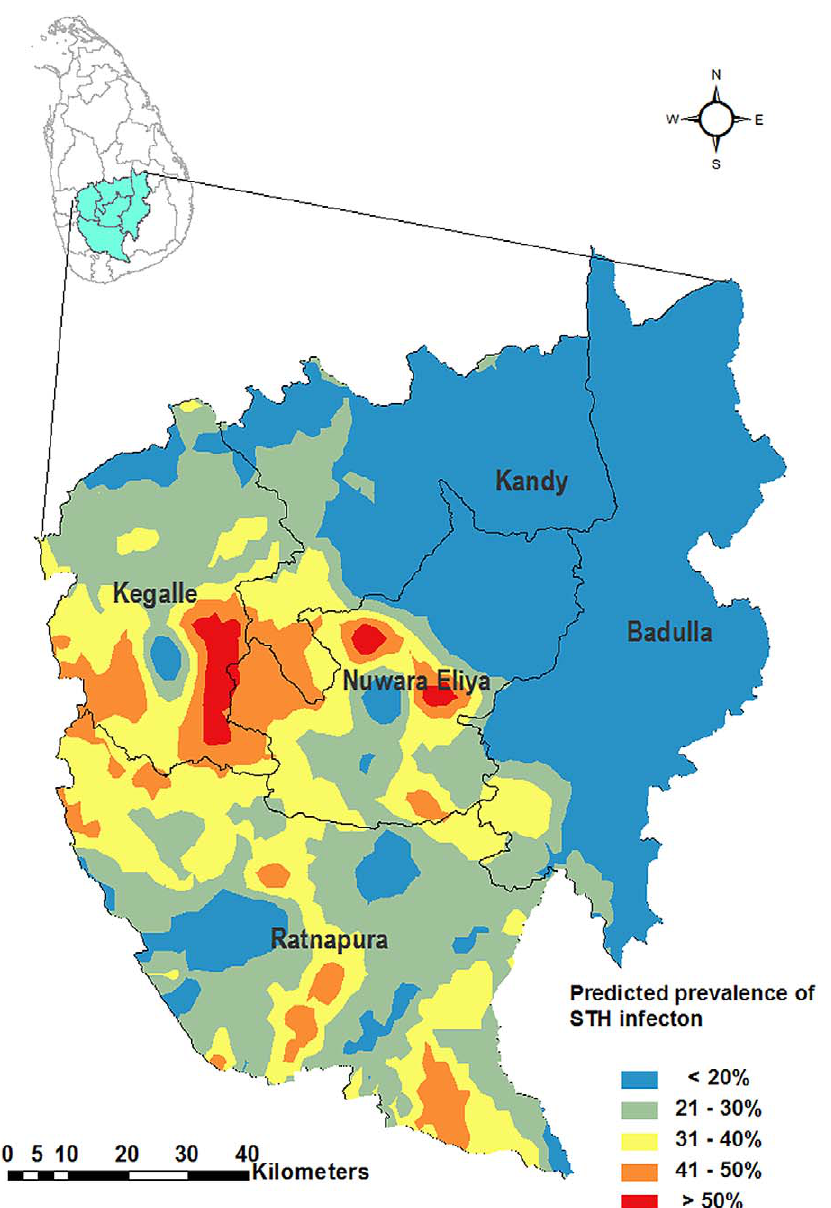
Figure 3. Predicted prevalence of infection with any one or more soil-transmitted helminth infection among children in the plantation sector in five districts of Sri Lanka.